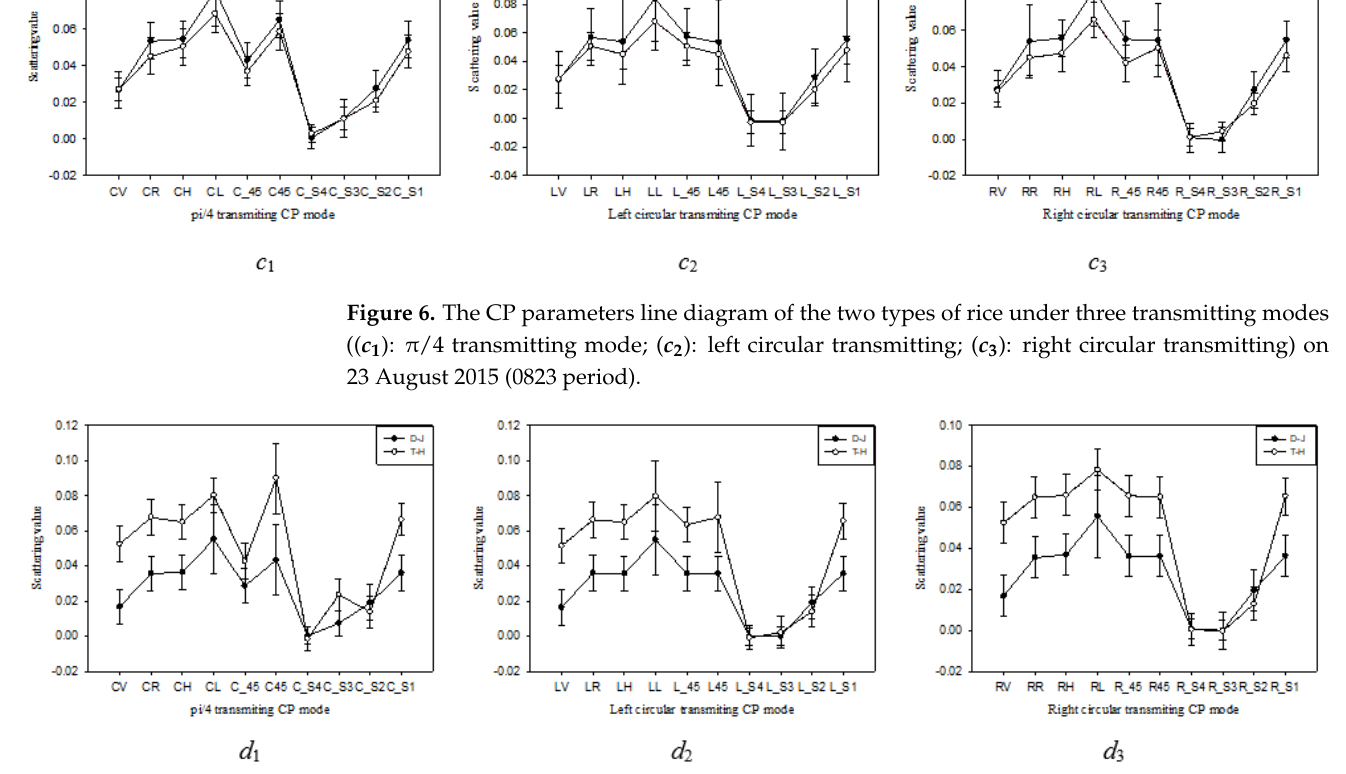
Figure 7. The CP parameters line diagram of the two types of rice under three transmitting modes